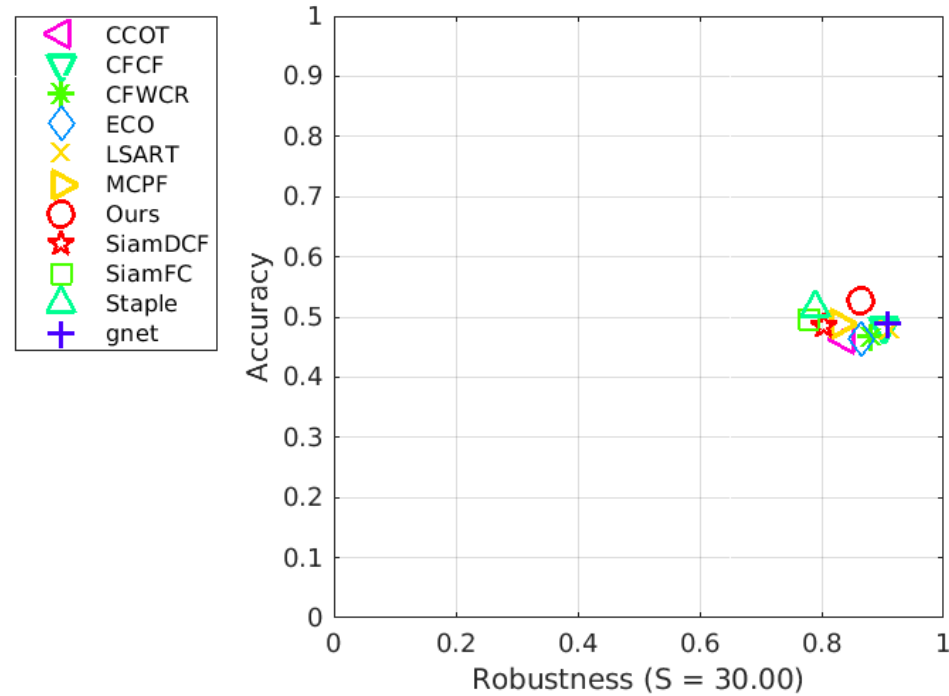
Figure 5. Quantitative comparison of our method with recent state-of-the-art deep-learning visual trackers using the VOT2017 dataset. Table 3. Quantitative comparison of our method with recent deep-learning-based visual tracking methods using the LaSOT dataset.